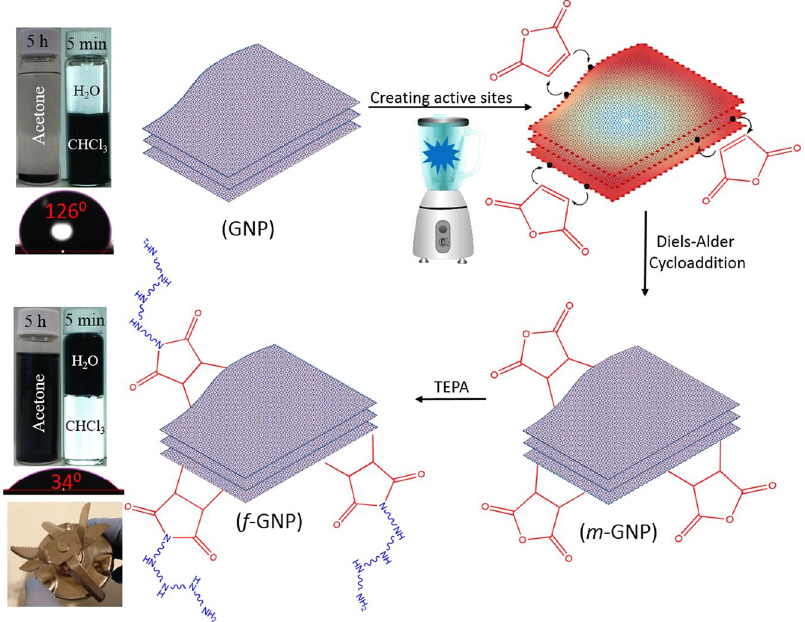
Figure 1. Kitchen blender assisted Diels-Alder based chemical synthesis of amino-functionalized graphene; and its solubility profiles and water contact